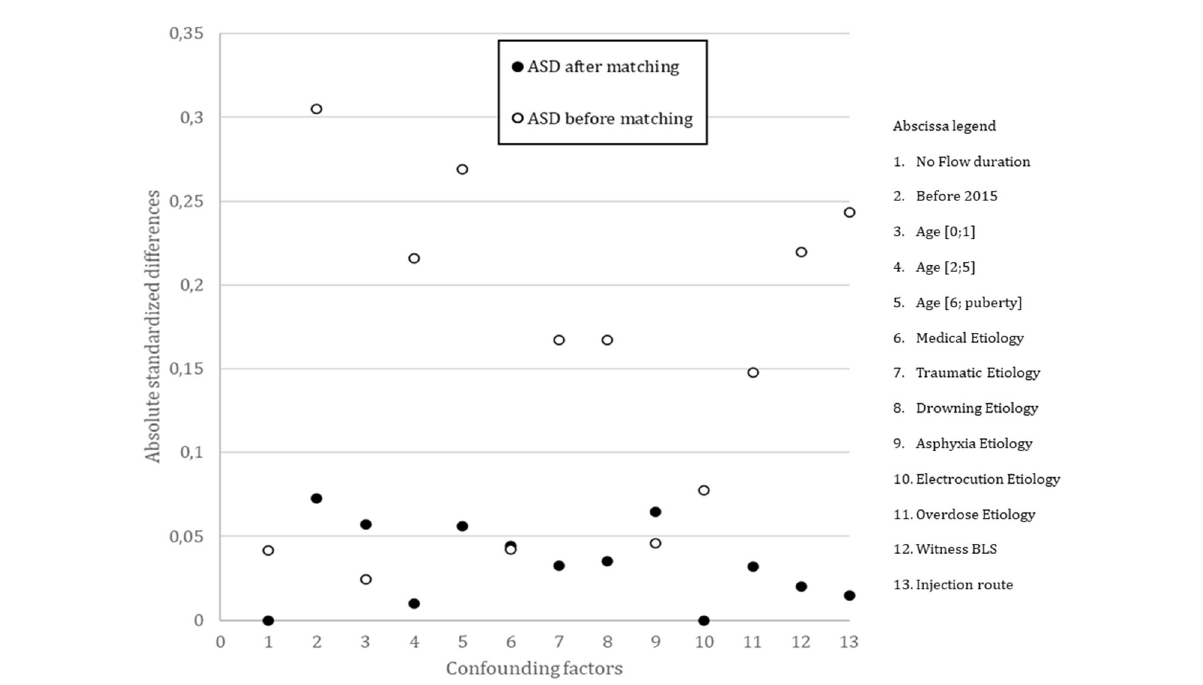
FIGURE3 Absolute Standardized Differences (ASD) between groups before and after propensity score matching. BLS, basic life